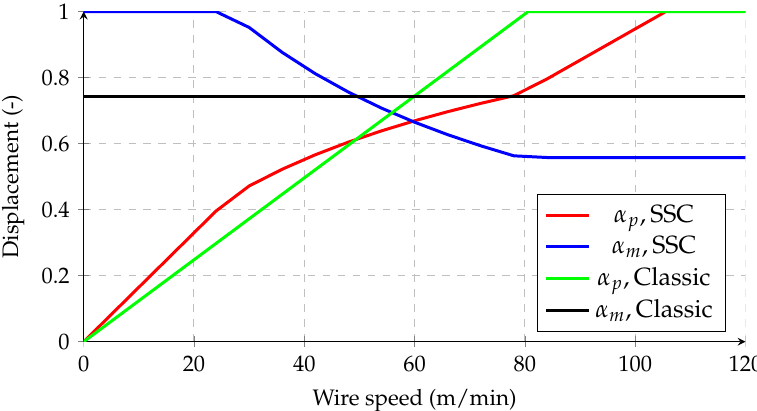
Figure 4. Steady-state motors’ and pumps’ displacement setting ( α m and α p